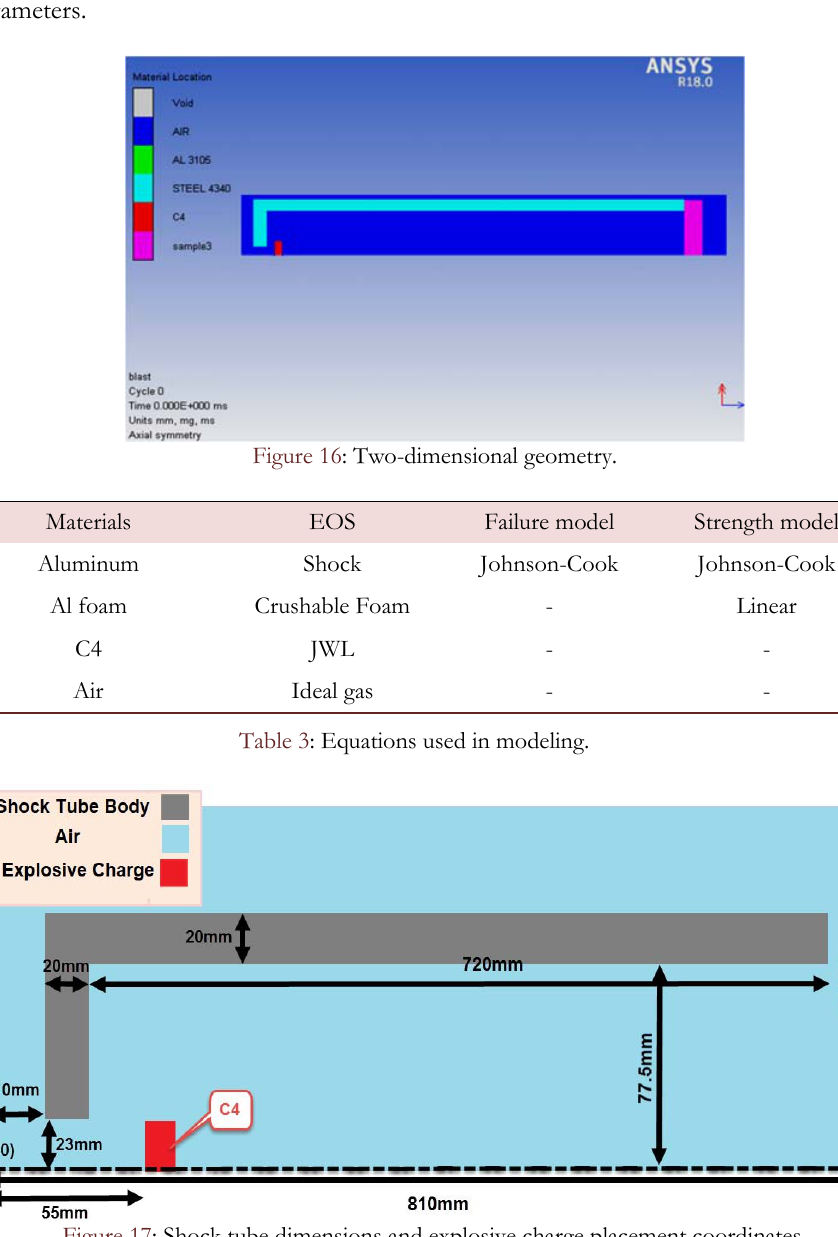
Figure 17: Shock tube dimensions and explosive charge placement coordinates.